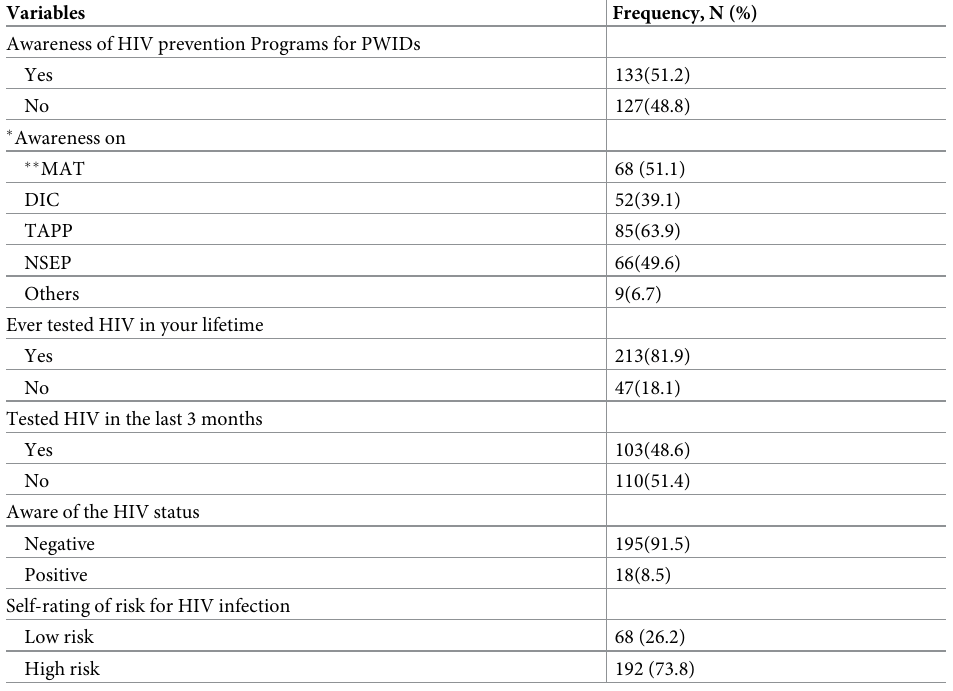
Table 3. Awareness of strategies for prevention of HIV infection (N = 260).